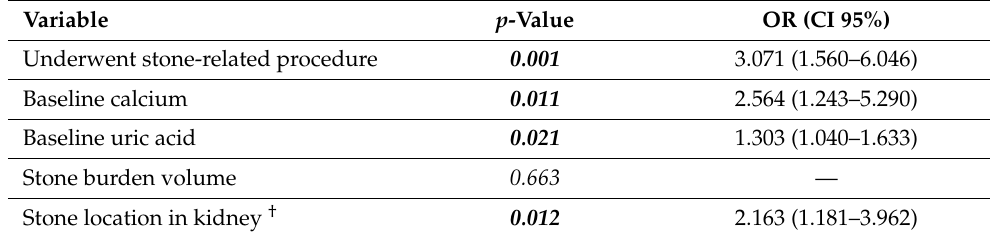
Table 5. Multivariate analysis, logistic regression. Boldface indicates statistically significant factors.